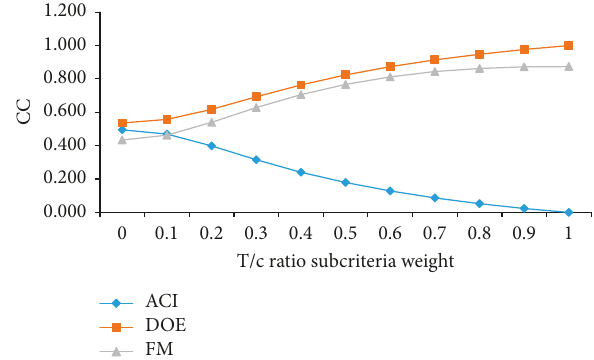
Figure 10: Sensitivity analysis of mix design methods with respect to T/c weight.